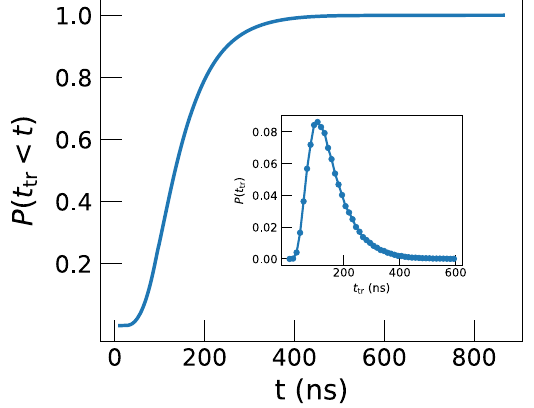
FIG. 13. Cumulative distribution function of the time duration of the trajectory to the critical point t (see text), for the nominal tr set of parameters and an electric field of 250 MV = m. The inset shows the probability distribution function, drawn as a histogram of forty-eight bins, each bin 12.5 ns wide. Both curves were found by simulating 10 5 breakdown events.